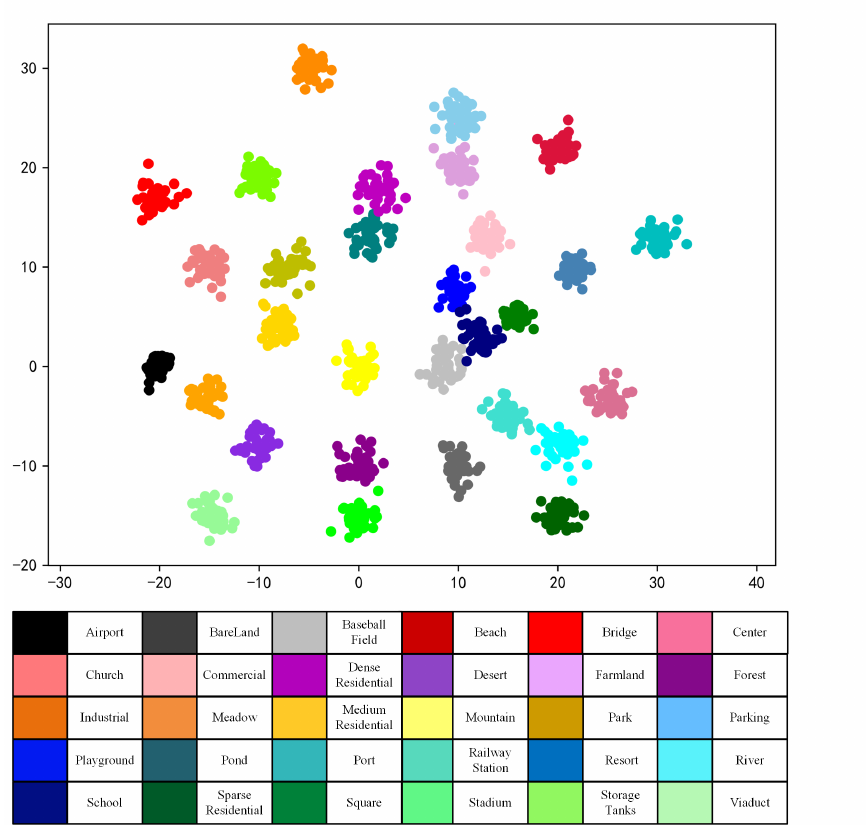
Figure 18. The T-SNE algorithm visualization results of our model on AID dataset.